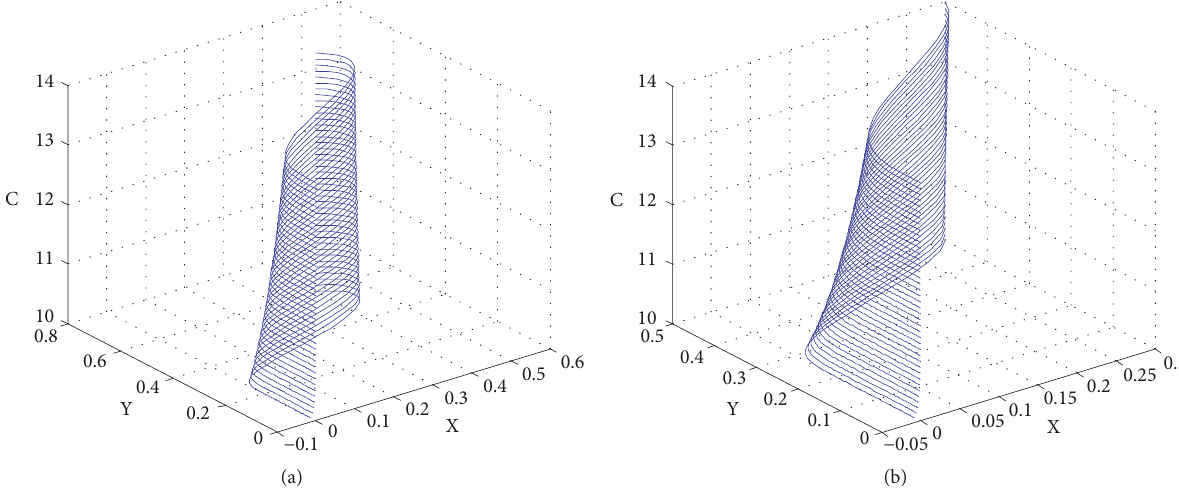
Figure 14: The change of C with respect to the initial values of (0.4,0.6) and (0.3,0.5) in Scenario 3.